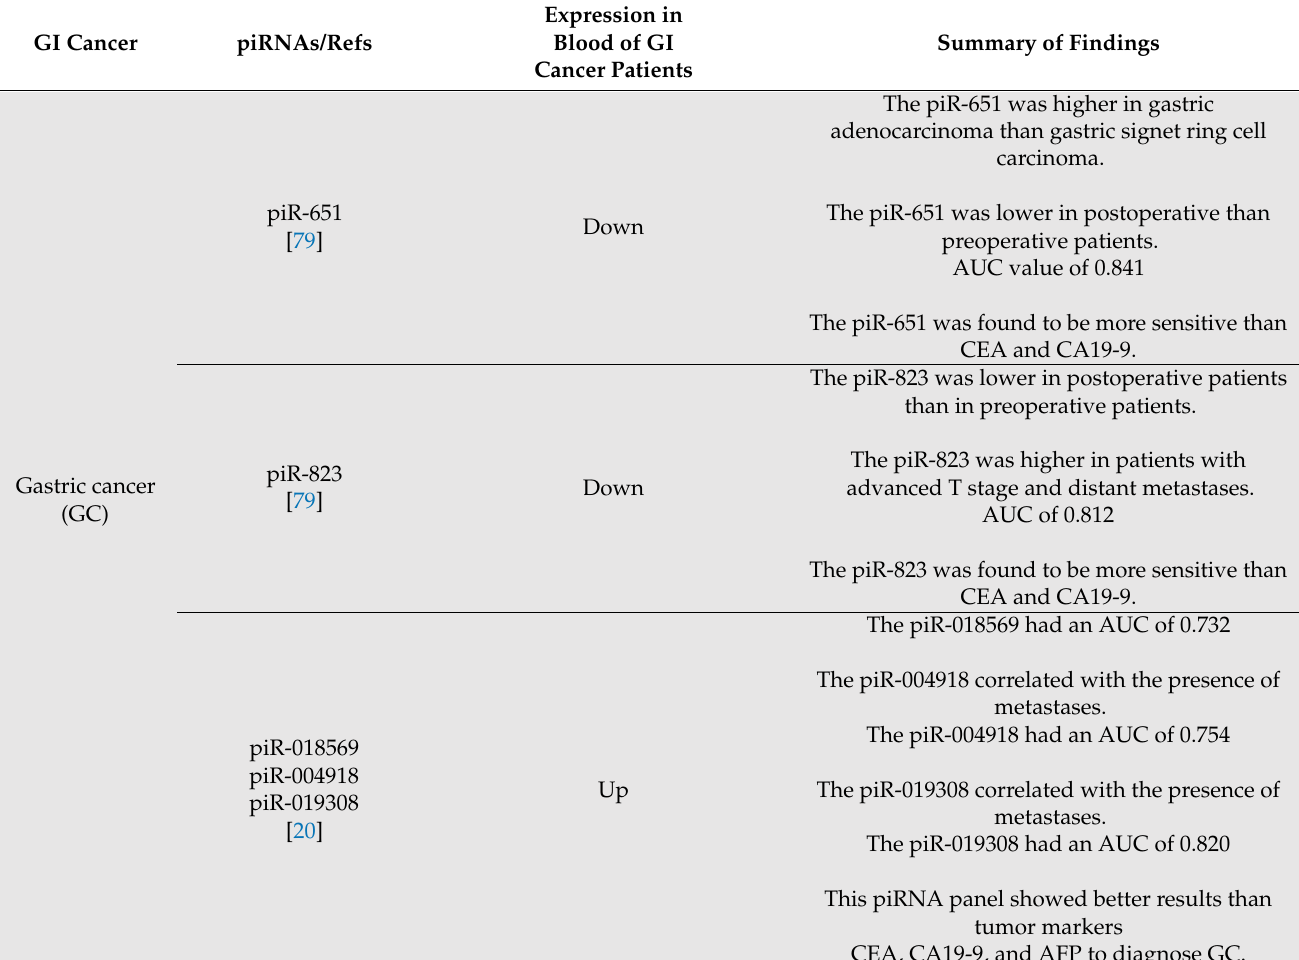
Table 2. The piRNAs as blood biomarkers in GI